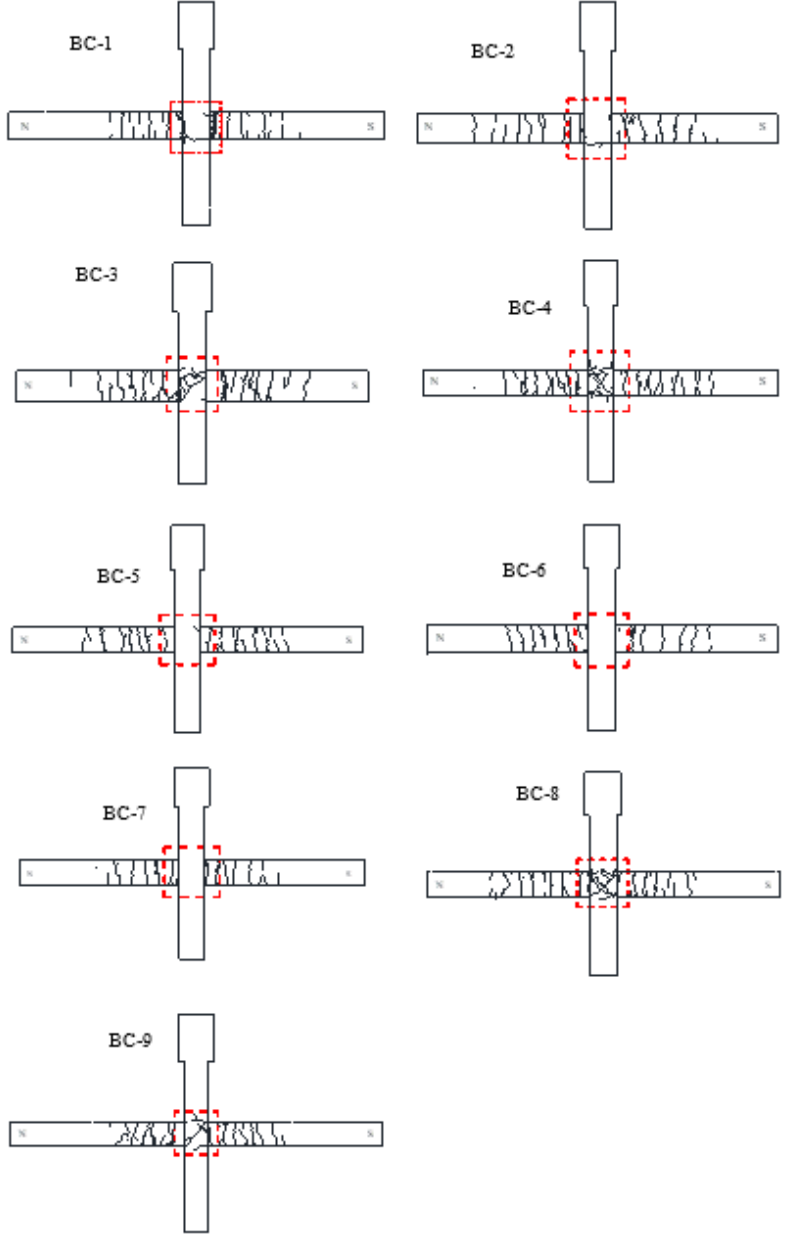
Figure 6. Crack pattern after testing. Compared to the RC joint specimen (BC-1), the GFRP beam-to-column joints emitted a brittle sound of fiber bundle breakage when the concrete spalled. Therefore, the surface concrete of the beam end where the cracks were concentrated was chiseled away to observe the damage situation of the GFRP, as shown in Figure 7. It can be inferred that the outer rubber layer of the GFRP was pulled off first due to the cyclic load, then the fiber filament bundle gradually appeared to fracture as the load increased, and finally, the internal rubber layer fragmentation occurred in a large area. From the observed damage of the GFRP, it can be concluded that, although GFRP are brittle materials, the GFRP joints still have some energy dissipation capabilities. Meanwhile, brittle damage did not appear when the GFRP joint specimens reached a displacement angle of 5.5%, indicating that the